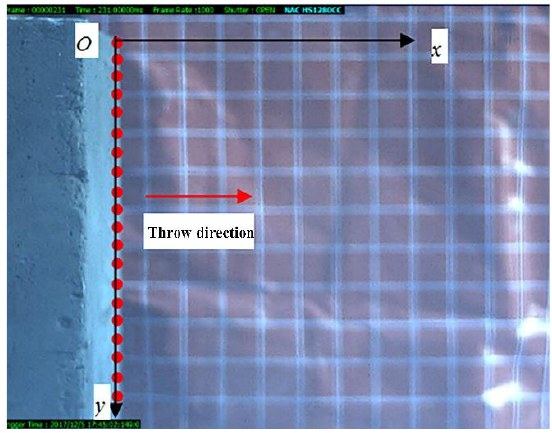
Figure 9. Relative coordinate system.